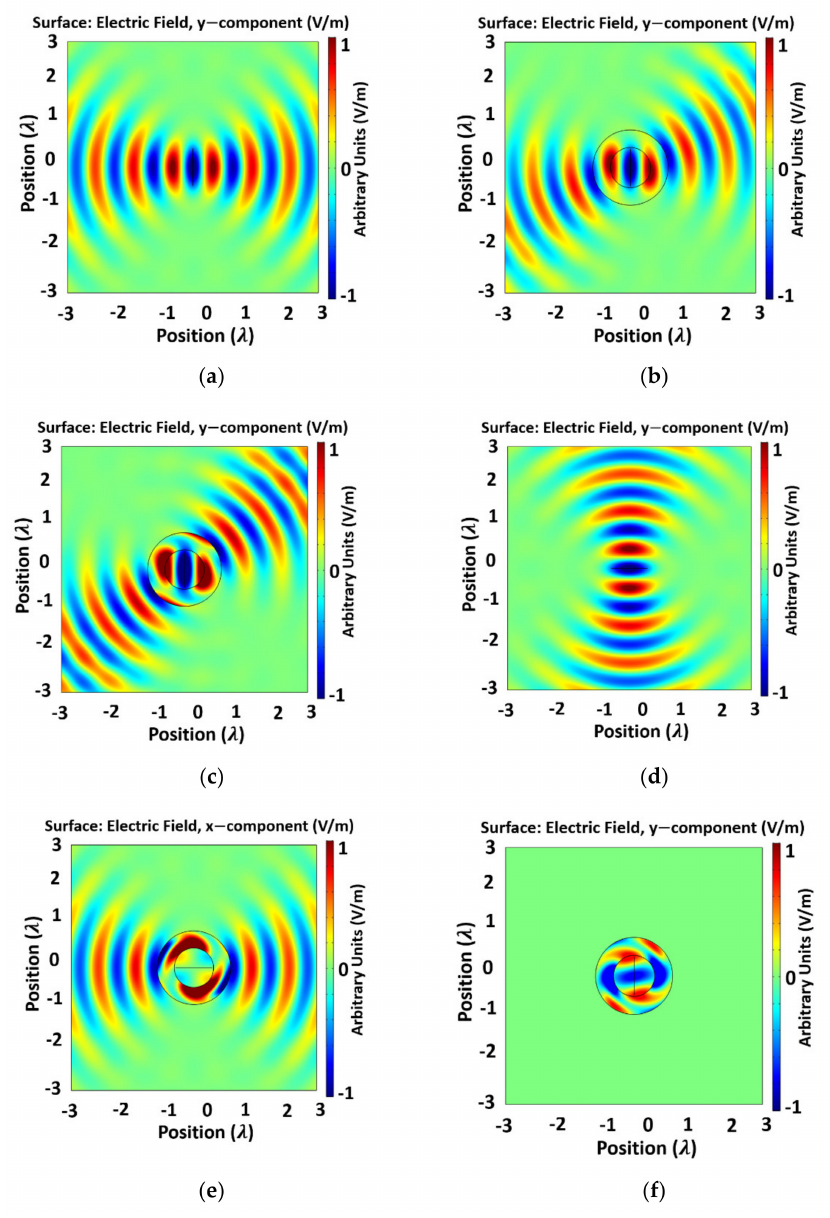
Figure 5. The electric fields of the proposed TO-based single element beam-steerer ( a ) dipole antenna of length L = λ in free-space along y-direction (vertical); ( b ) the fields of the vertical dipole that have undergone a rotation of β = 22.5 ◦ ; ( c ) the fields of the vertical dipole that have undergone a rotation of β = 45 ◦ ; ( d ) dipole antenna of length L = λ in free-space along x-direction (horizontal); ( e ) the fields of the horizontal dipole that have undergone a rotation of β = 90 ◦ ; ( f ) difference between the magnetic fields in ( a ) and ( e